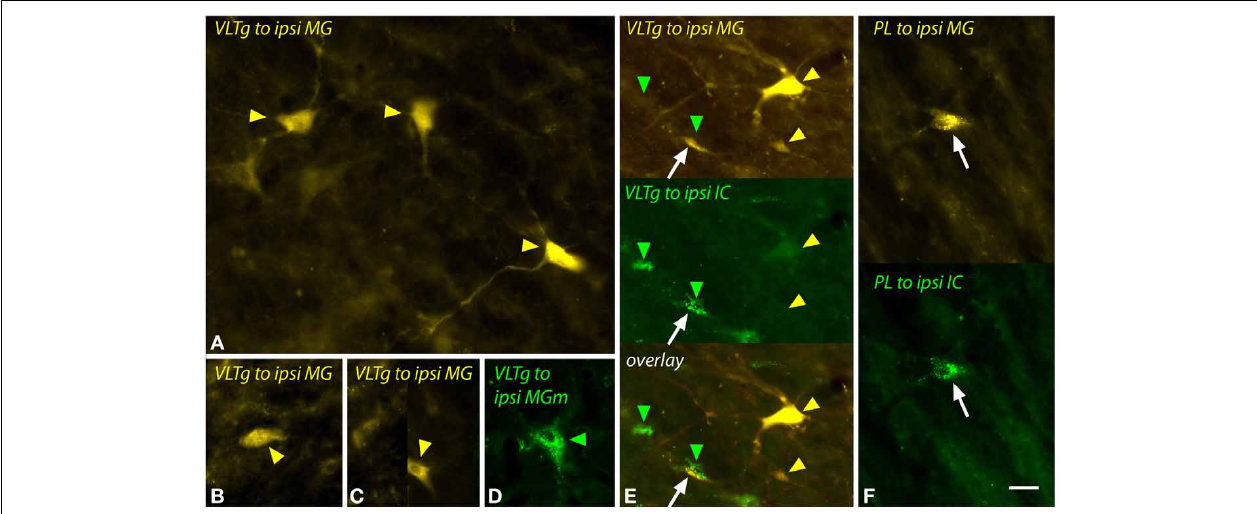
FIGURE 11 | Photomicrographs showing labeled cells in the ventrolateral tegmental nucleus (VLTg) and the paralemniscal area (PL) after injections into the medial geniculate nucleus (MG) and the inferior colliculus (IC). (A–C) Cells in the left VLTg labeled after a large injection of FluoroGold into the left MG (GP597). (D) Large multipolar cell in the right VLTg labeled by an injection of green beads into the ipsilateral MGm (GP689). ( E) Single-labeled cells (green and yellow arrowheads) and a double-labeled cell (white arrow) in the left VLTg after injections of FluoroGold into the left MG and green beads into the left IC (GP597). The top panel shows FluoroGold label, the